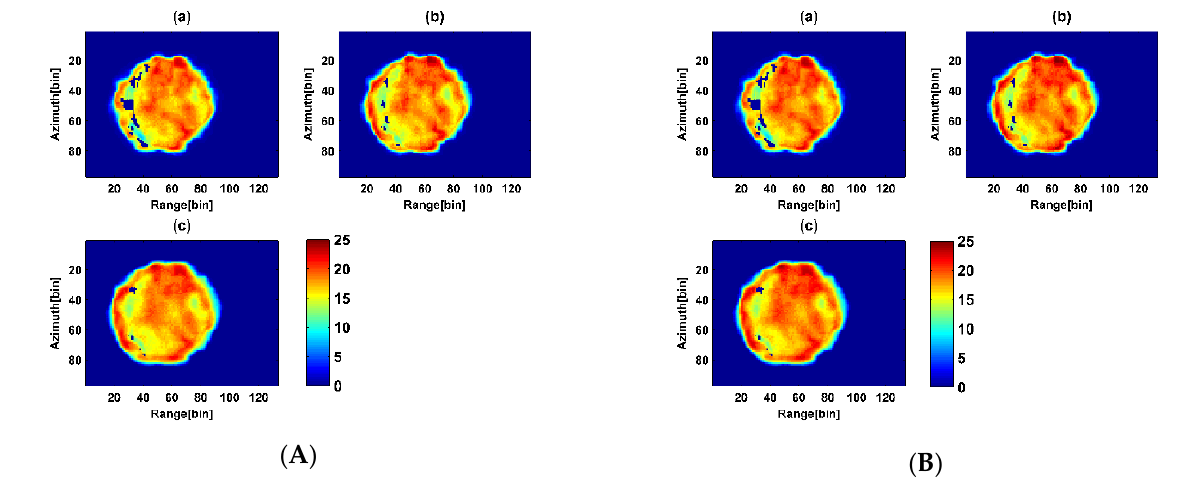
Figure 8. Improved three-stage method for forest height inversion. ( A ) Three-stage method for forest height inversion based on coherence optimization ( a ) HV ( b ) PD ( c ) MCD ( B ) After introduction coherence amplitude for Forest height inversion ( a ) HVWeight ( b ) PDWeight ( c ) MCDWeight.